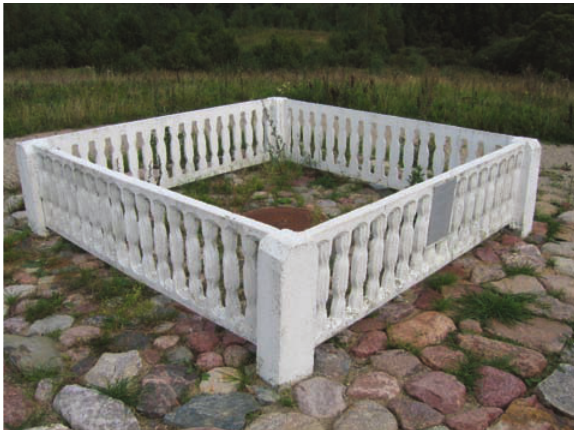
Fig. 4. Monumentation of Struve Arc Point Meškonys in Lithuania: Natural stones and lime safeguarding. Remonumented with concrete in the 1930s, renovated in 1992. Now surrounded by a 0.5